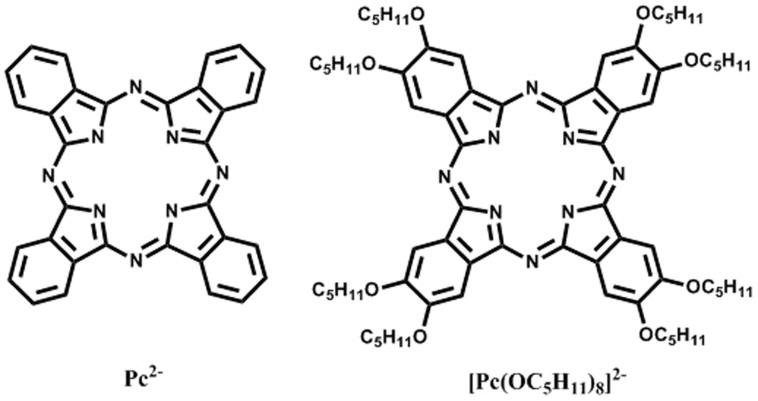
Schematic structures of Pc2− and [Pc(OC5H11)]2−.